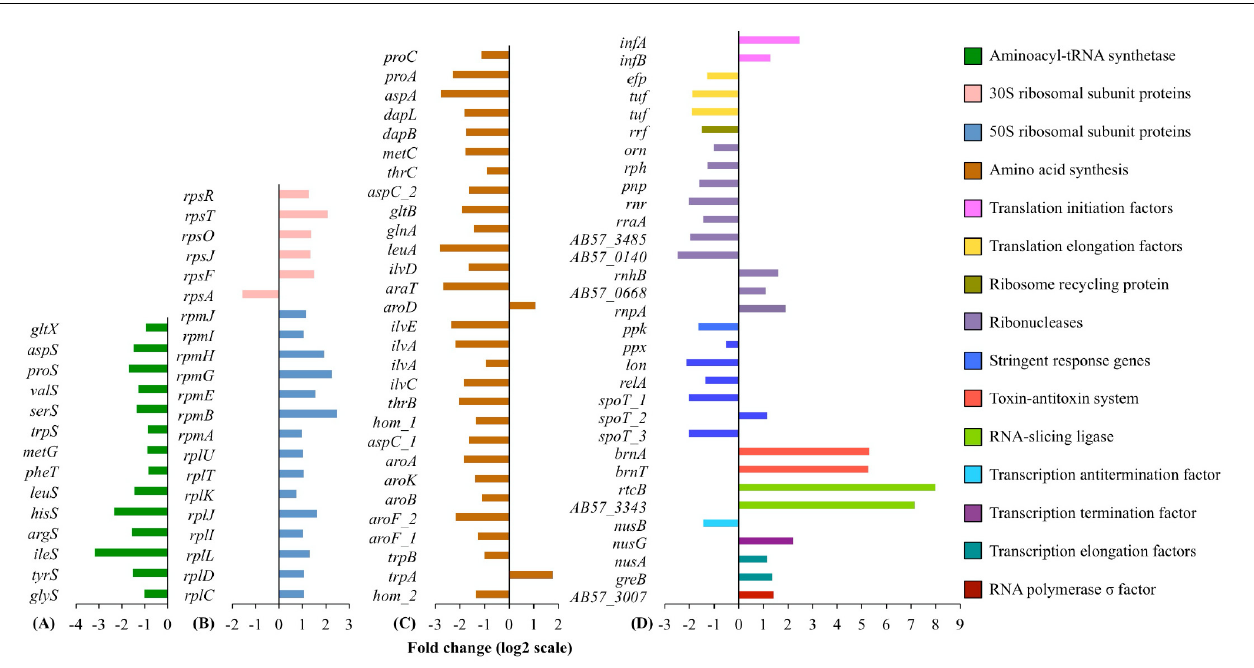
FIGURE 1 | (A) Aminoacyl-tRNA synthetases, (B) ribosomal proteins, (C) amino acid synthesis, and (D) others. Differential expression of genes involved in, or affecting, protein translation. For each functional group or cellular pathway, only differentially transcribed genes with absolute fold changes > 1 (log 2 scale) and padj < 0.01 are shown. The bar charts are grouped by colors according to the biological functions of the genes assigned, with the color scheme on the right. Full information on gene function annotations is given in Supplementary Data